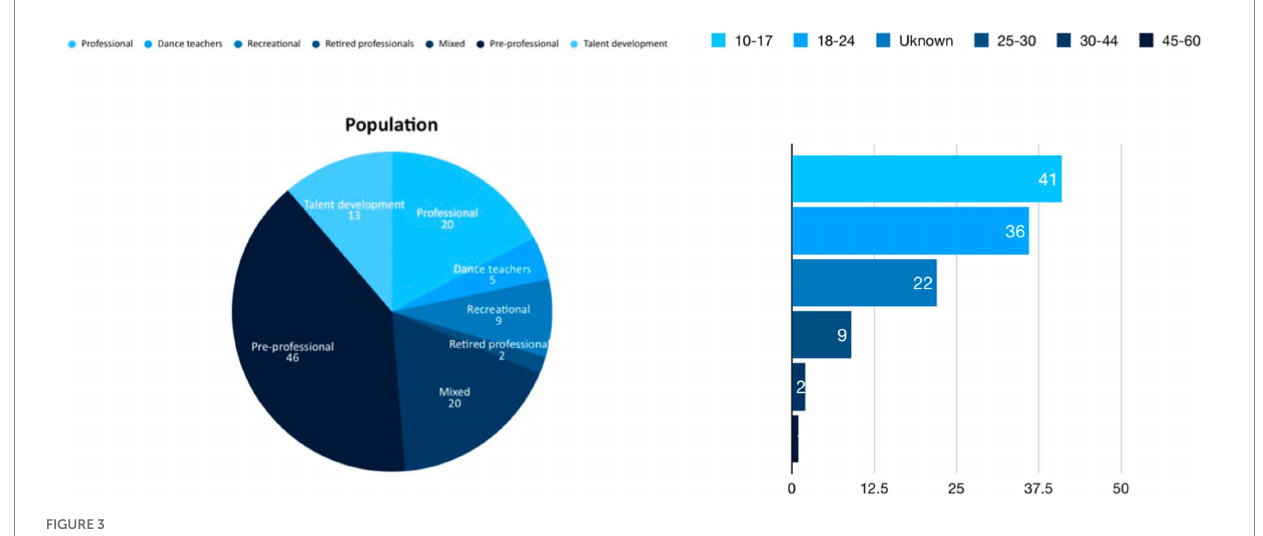
FIGURE 3 Overview of researched population and